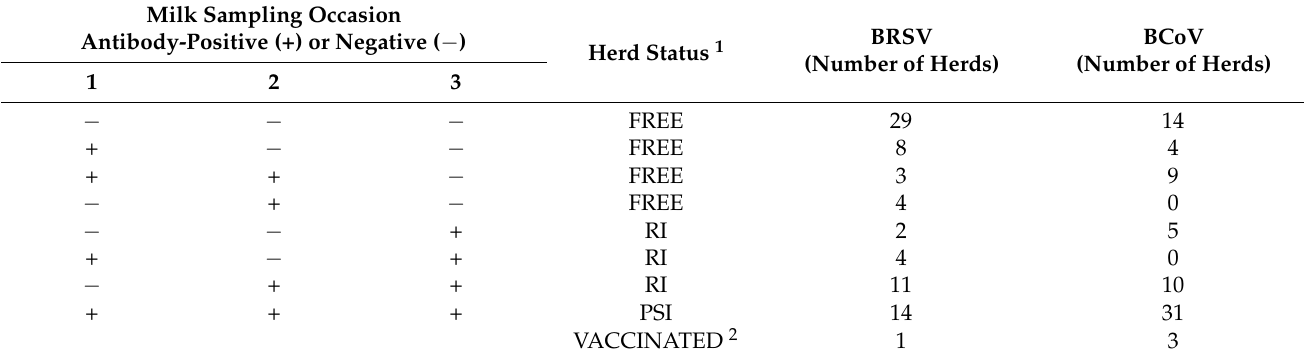
Table 1. Categorization of herd infection status according to the herd antibody status in each milk sampling for bovine respiratory syncytial virus (BRSV) and bovine coronavirus (BCoV) in 76 dairy herds. Milk Sampling Occasion Antibody-Positive (+) or Negative ( − )